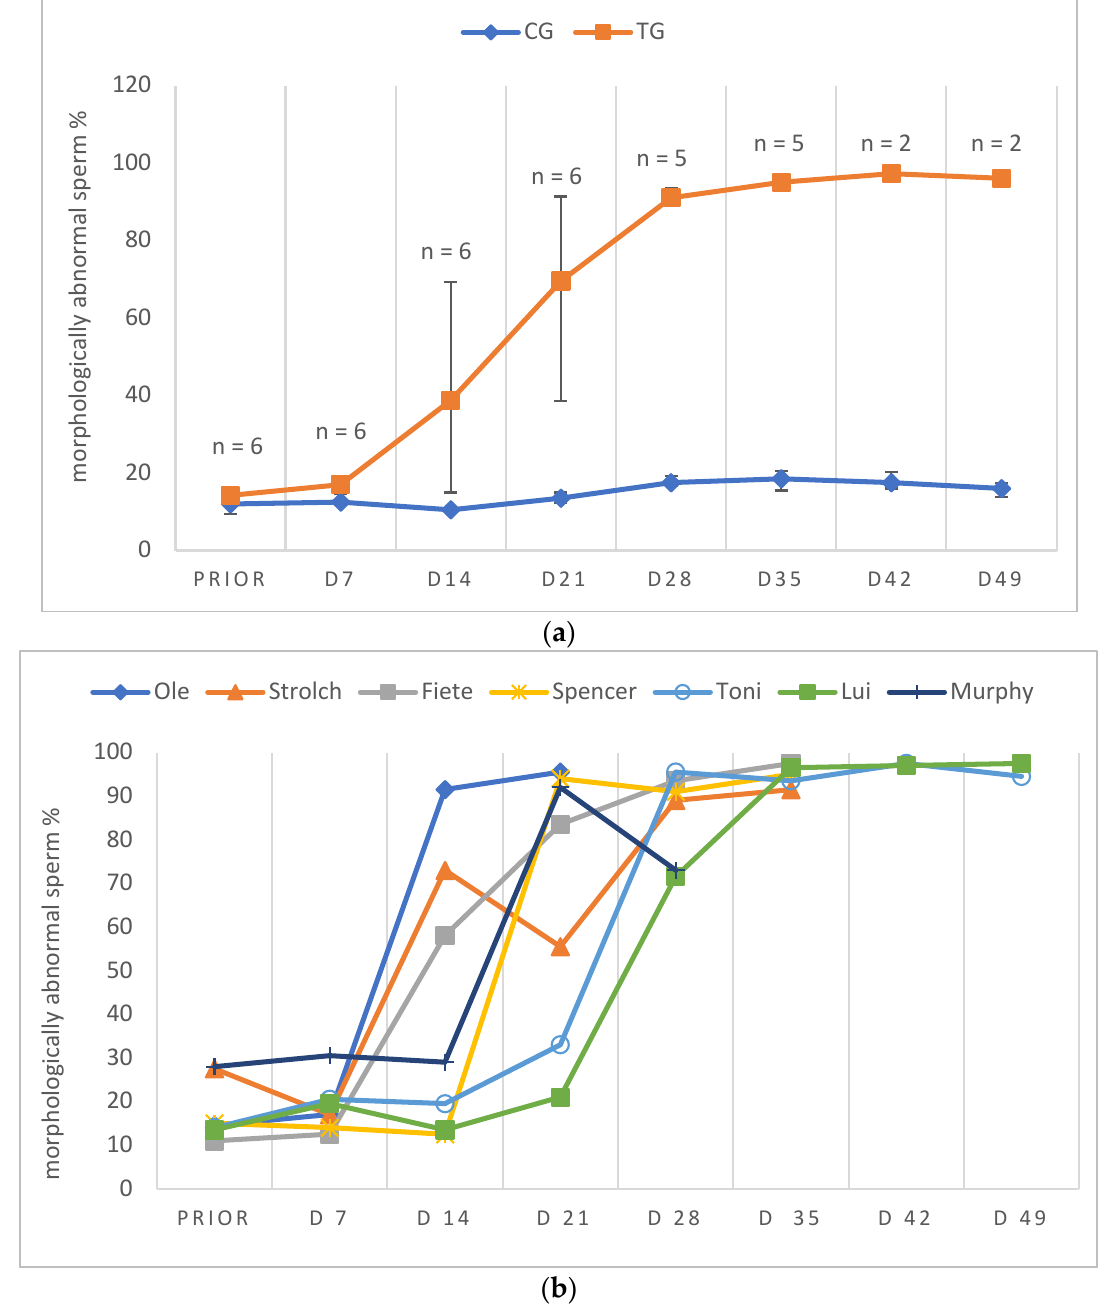
Figure 7. ( a ) Percentage of morphologically abnormal sperm given as median (Q1, Q3) over time of animals treated with a 4.7 mg deslorelin implant (TG, n = 6, if not indicated otherwise) and saline-treated control animals (CG, n = 3). “Prior” indicates “prior to treatment”. ( b ) Percentage of morphologically abnormal sperm given as individual courses of animals treated with a 4.7 mg deslorelin implant (TG, n = 7) over time. “Prior” indicates “prior to treatment”.